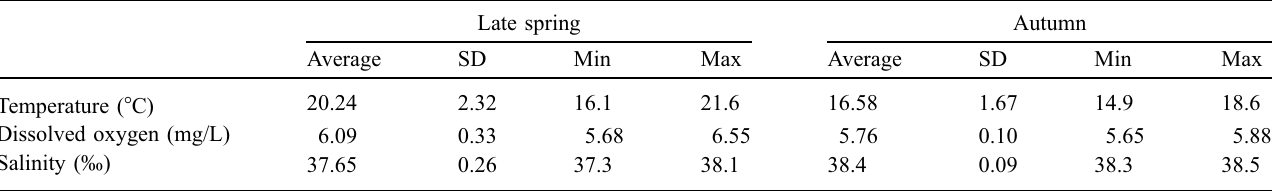
Table 2. Physicochemical characteristics of rearing sea water at sampling locations on the tuna farm.